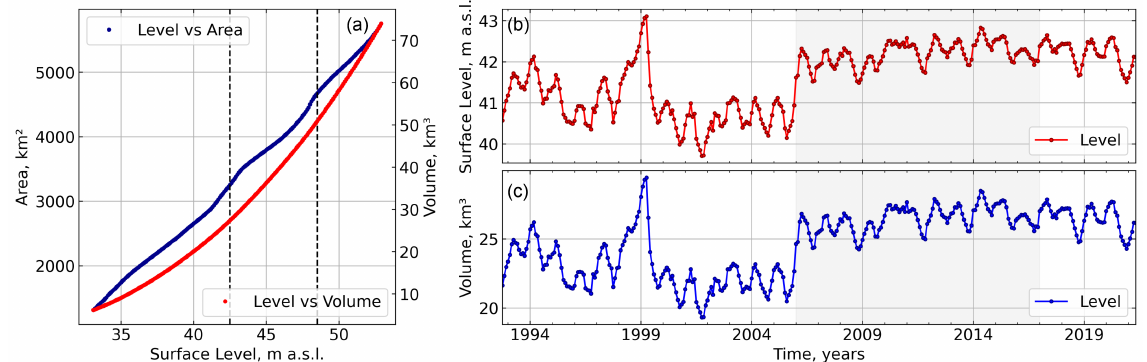
Figure 2. Hypsometric relation for the Small Ara Sea ( a ), dashed vertical lines correspond to 42.5 m and 48.5 m surface level benchmarks. Fluctuations of lake surface level according to satellite altimetry ( b ) and fluctuations of lake volume according to bathymetry model calculations ( c ). The validation period for the water balance model is highlighted in